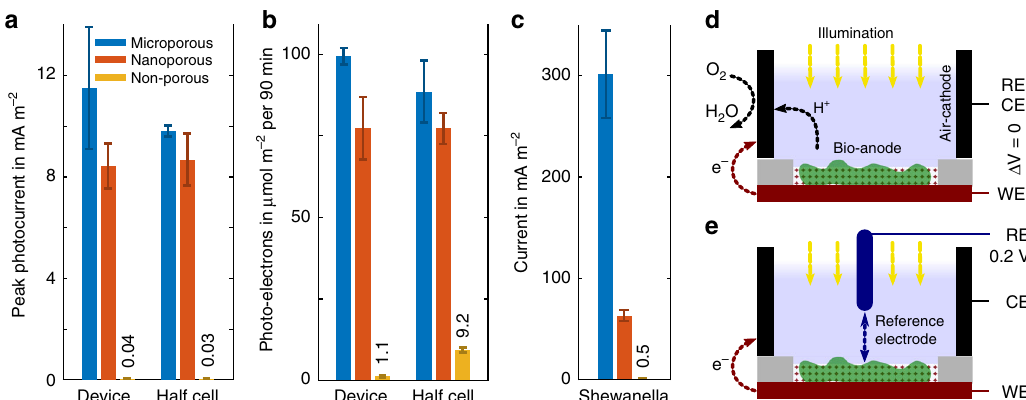
Fig. 4 Current levels by anode type and device con fi guration. a Synechocystis peak photocurrents in device mode (at ‘ short-circuit ’ ) and half-cell operation (with reference electrode), during a photon fl ux of 460 µ mol m − 2 s − 1 . b As ( a ), number of collected charges during 90 minutes of illumination at photon fl ux of 512 µ mol m − 2 s − 1 . c Current generated by Shewanella cells for each anode type. d , e Schematic illustrating the device and half-cell operation, respectively. The potentiostat connections for reference (RE), working (WE) and counter electrode (CE)